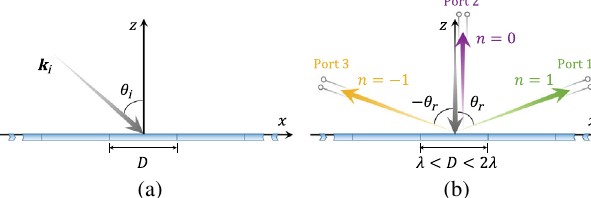
FIG. 1. (a) Illustration of a periodic metasurface illuminated by a plane wave impinging from an angle θ i . (b) A periodic metasurface illuminated at θ i ¼ 0 °. The three propagating har- monics of the metasurface are analogous to a three-port network.